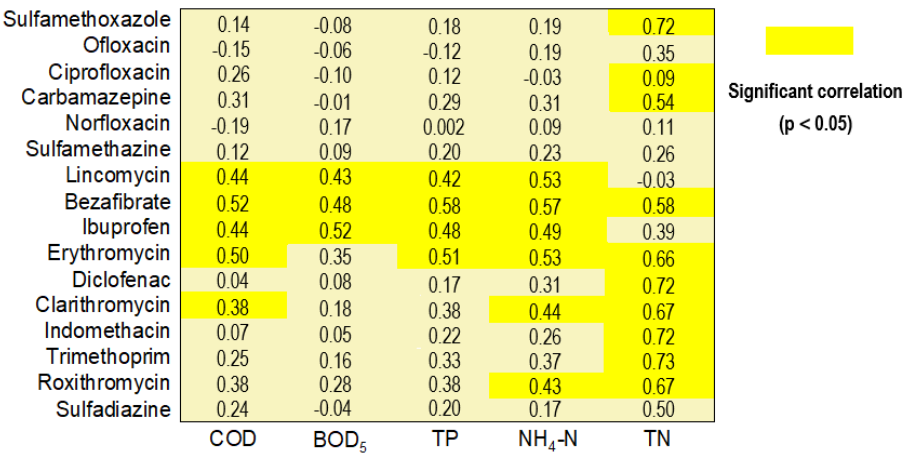
Figure 6. Spearman’s correlation coefficients between PPCPs and conventional water Figure 6. Spearman ’s correlation coefficients between PPCPs and conventional water pollutants.